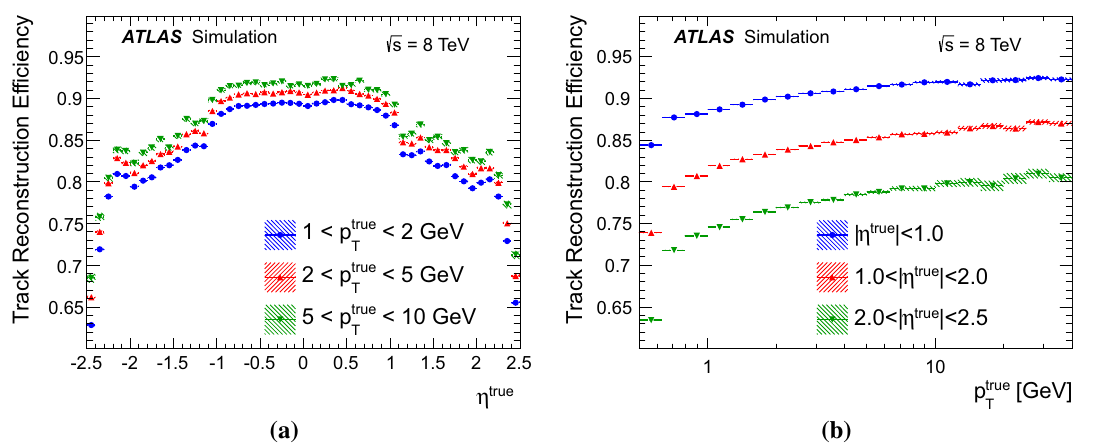
Fig. 8 The track reconstruction efficiency for charged pions after applying the tight quality selection criteria to the tracks. Subfigure ( a ) shows the efficiency for 1–2GeV, 2–5GeV and 5–10GeV parti- cles as a function of η , while ( b ) shows the track reconstruction effi-